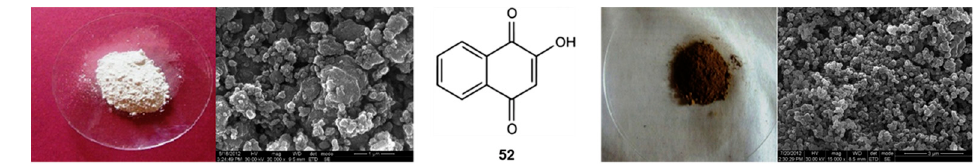
Figure 13. Nanoparticle powder and SEM images of pure TiO 2 and pre dye 52 treated TiO 2 . Reprinted from [96], with permission from Elsevier.